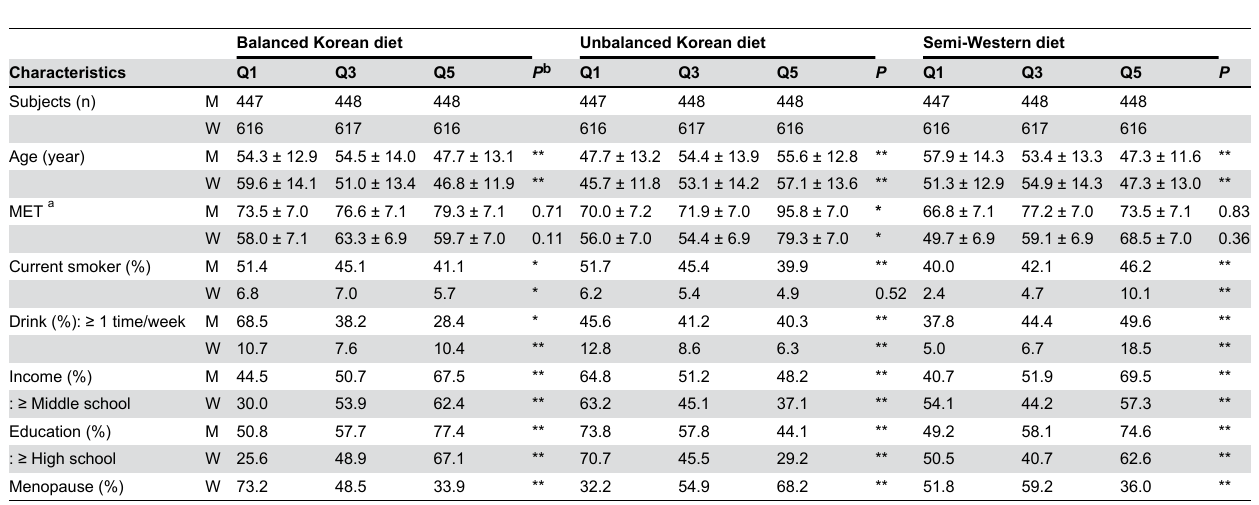
Table 2. General characteristics by the quintiles of major three Korean diets based on the KNANES 2007-2008 (n=5,320, 2,239 men and 3,081